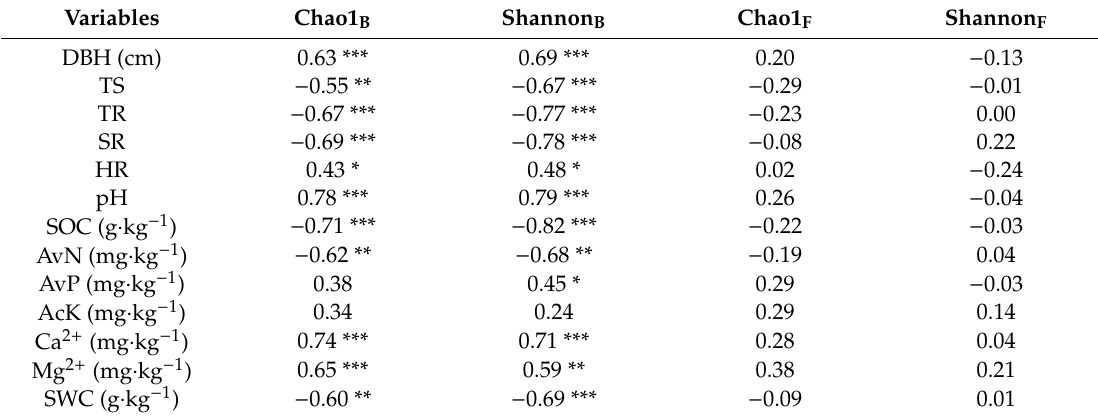
Table 3. Spearman correlations of bacterial (B) and fungal (F) diversity with plant traits and soil